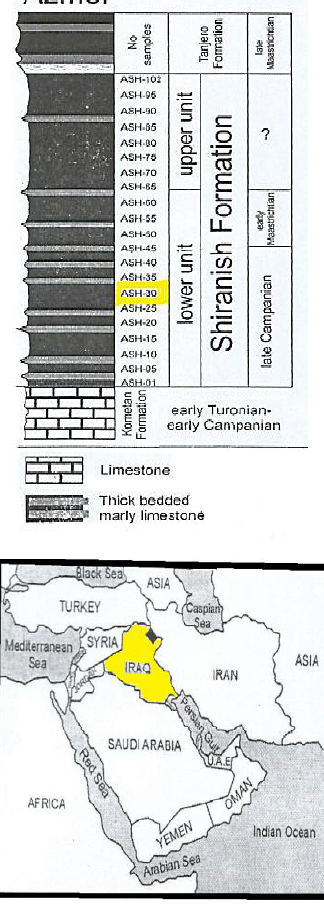
Figure 3: The stratigraphic section and location map of Azmer section, NE Iraq (Jaff and Lawa,